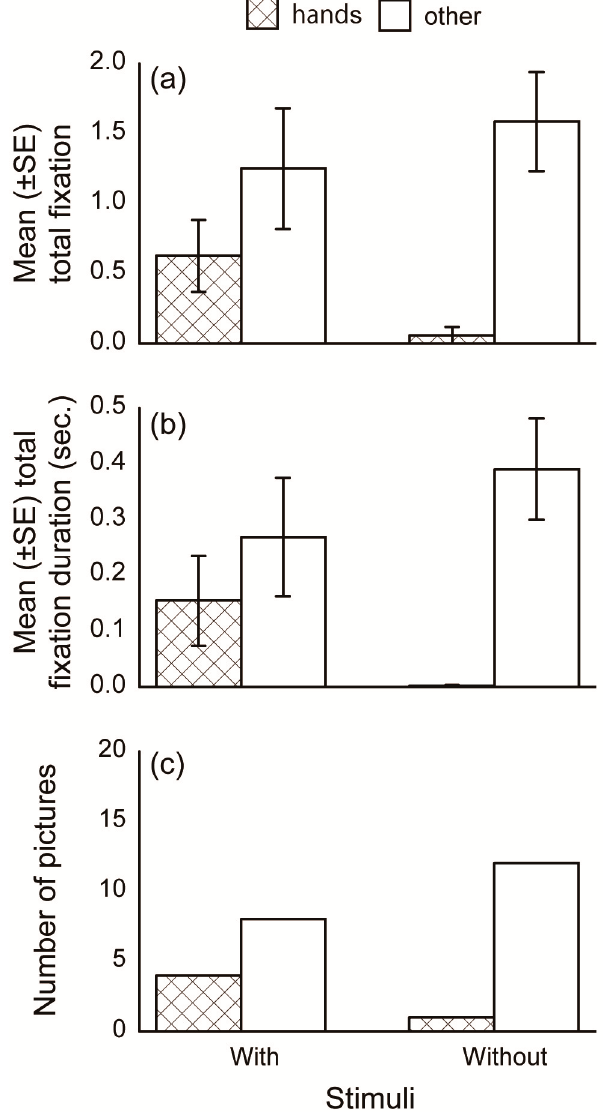
Figure 6. Mean ( ± SE) fixation number, mean ( ± SE) total fixation duration, and the number of pictures Figure 6. Mean (± SE) fixation number, mean (± SE) total fixation duration, and the number of pictures categorized into each first gazed AOI for human pictures with and without hand categorized into each first gazed AOI for human pictures with and without hand signs.